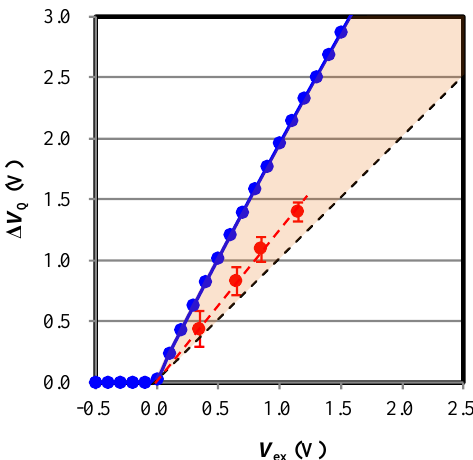
Figure 3. The voltage drop after the quenching ( = ∆ V Q ) with respect to the initial bias ( = V 0 ). The blue dots connected by line, the black dashed line, and the red circles connected by dashed line denote, respectively, the calculated results of ∆ V Q , ∆ V Q = V ex , and the experimental result. A red hatched area is a region between calculated curves; ∆ V Q and ∆ V Q = V ex , where experimental results fall within. It is noted that the measured results of ∆ V Q are converted from the actually measured voltage of a sensing node or a floating di ff usion (FD) by taking account of the capacitance values of a SPAD and FD.